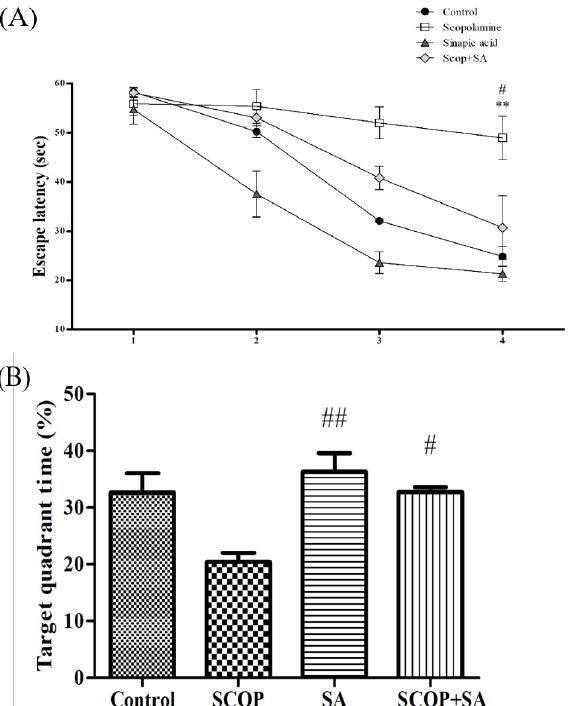
Figure 6. The effect of SA on long-term spatial memory in SCOP-treated. ( A ) Escape latency in the MWM test during 4 days of the training session. ( B ) Percent of time in the target zone during 60 s of the probe trial. n = 4. ** p < 0.01 vs. the control group. ## p < 0.01, # p < 0.05 vs. the SCOP group. Analyzed by one-way ANOVA with LSD test.